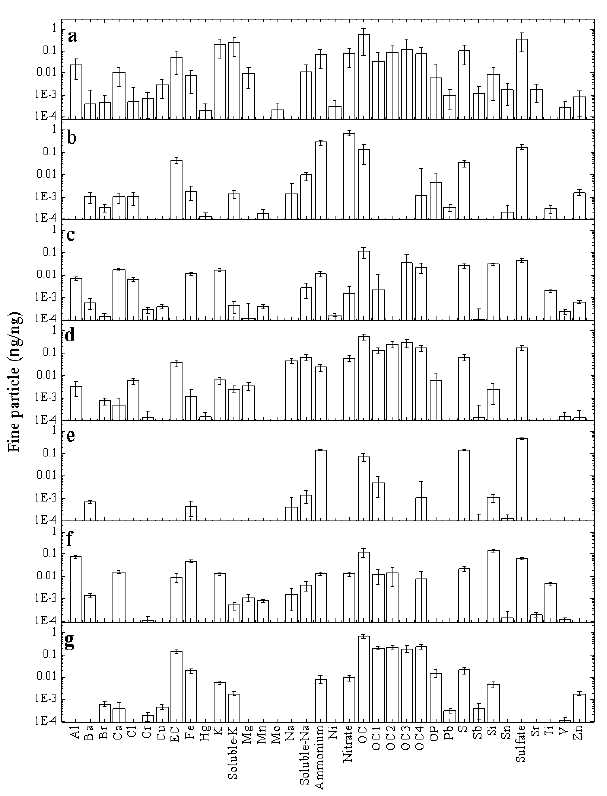
Figure 3. Profiles of primary traffic particles (a), secondary nitrate (b), diesel emissions (c), 2 Fig. 3. Profiles of primary traffic particles (a) , secondary nitrate (b) , aged sea salt (d), secondary sulphate (e), mineral dust (f) and biomass burning (g) in Little 3 diesel emissions (c) , aged sea salt (d) , secondary sulphate (e) , min- Rock, Arkansas. 4 eral dust (f) and biomass burning (g) in Little Rock,